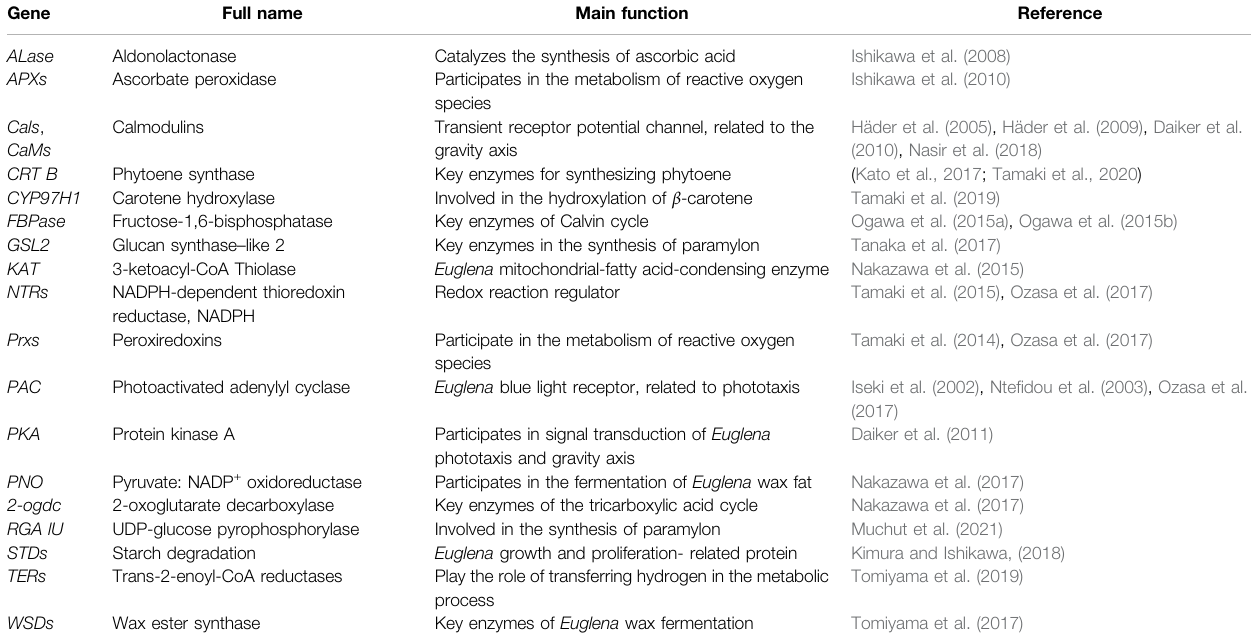
TABLE 1 | Studies on the gene function of E. gracilis by RNAi